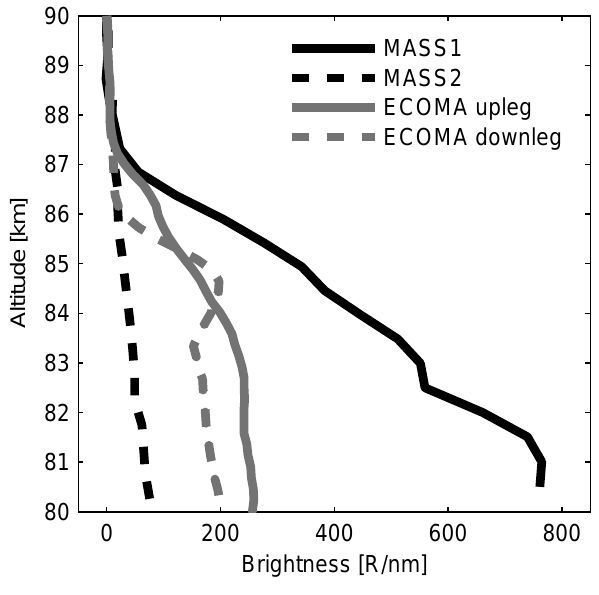
Fig. 2. Brightness (non-differentiated column radiance) at 55 ◦ so- lar scattering angle for the four different measurements. The cloud passage is characterised by a general strong decrease of signal with respect to increasing altitude, much exceeding the slow decrease of the background Rayleigh signal. The straight line of the MASS2 measurement clearly shows the absence of NLC during this flight. The background stray light remaining at 90km has been